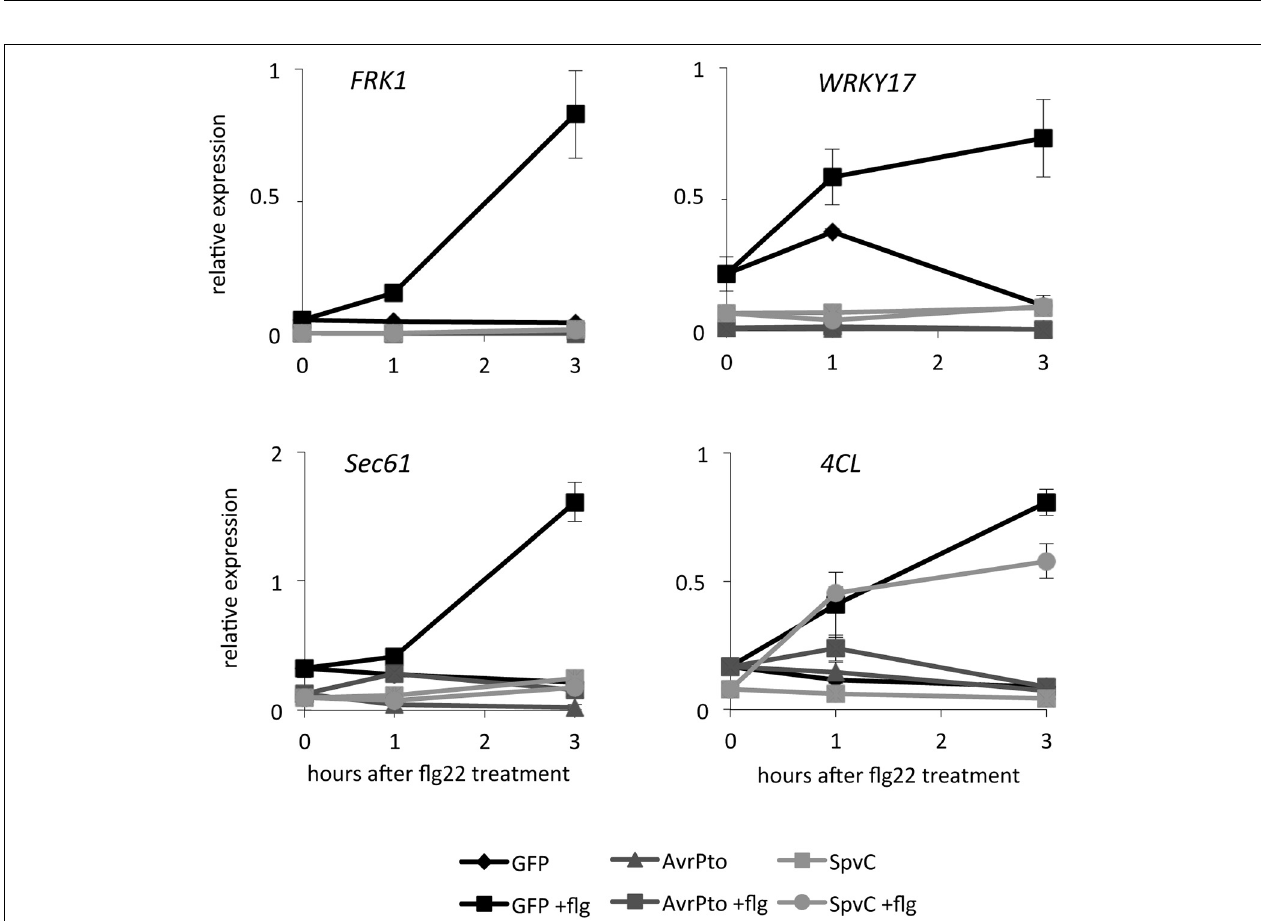
FIGURE 3 | SpvC attenuates flg22-induced defense responses in protoplasts. Arabidopsis mesophyll protoplasts were transformed with p2FGW7 (GFP), p2GW7-AvrPto (AvrPto) or p2GW7-SpvC (SpvC) plasmids and subsequently challenged with flg22. Samples were collected 1 and 3 h after treatment. Relative expression levels of FRK1 , WRKY17 , Sec61, and 4CL were assessed using quantitative RT-PCR and